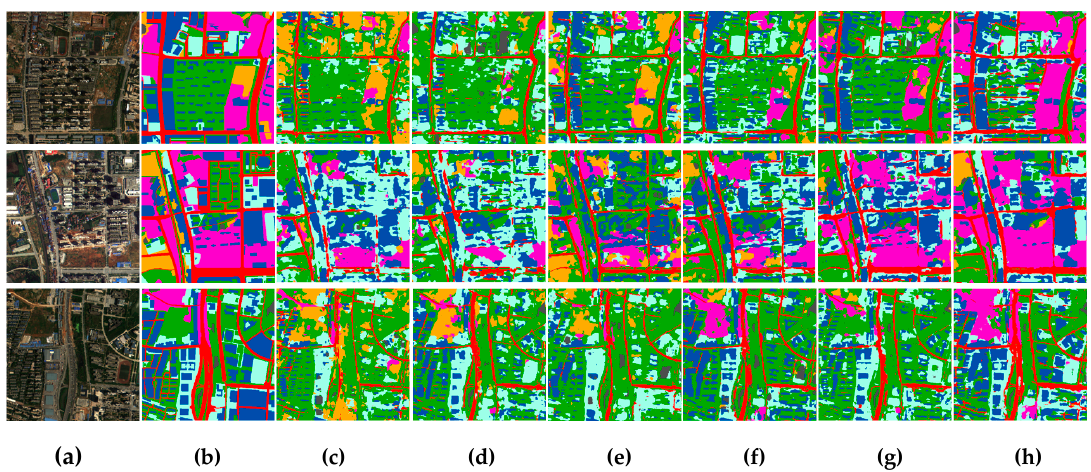
Figure 6 . Classification results of different FCN structures. ( a ) and ( b ) are the images and ground truth, ( c – h ) Figure 6. Classification results of di ff erent FCN structures. ( a ) and ( b ) are the images and ground truth, are the results of FCN-16, U-Net, Dense-Net, Deeplab-v3, SR-FCN and ours. ( c – h ) are the results of FCN-16, U-Net, Dense-Net, Deeplab-v3, SR-FCN and ours. Table 2. The confusion matrix of our method on the patch samples.